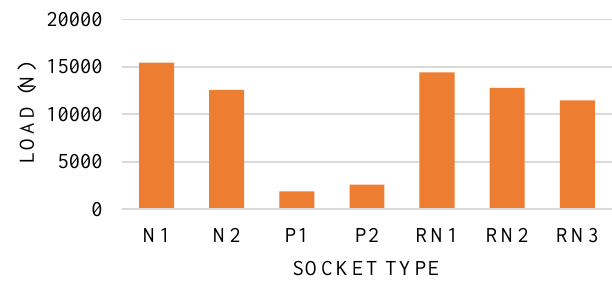
Figure 1: Ultimate strength at failure for different